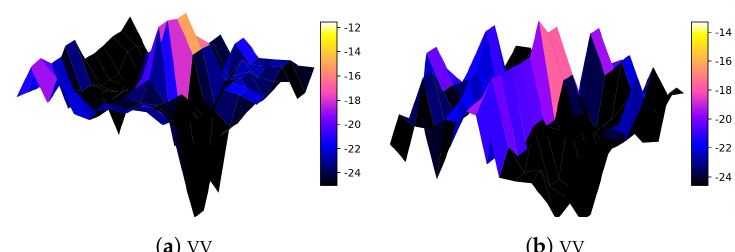
Figure 10. 3D representations of the vessel’s radar footprint in S1 Interferometric Wide (IW) swath mode (©ESA, 2017) with indications for polarization and special scene or sensor